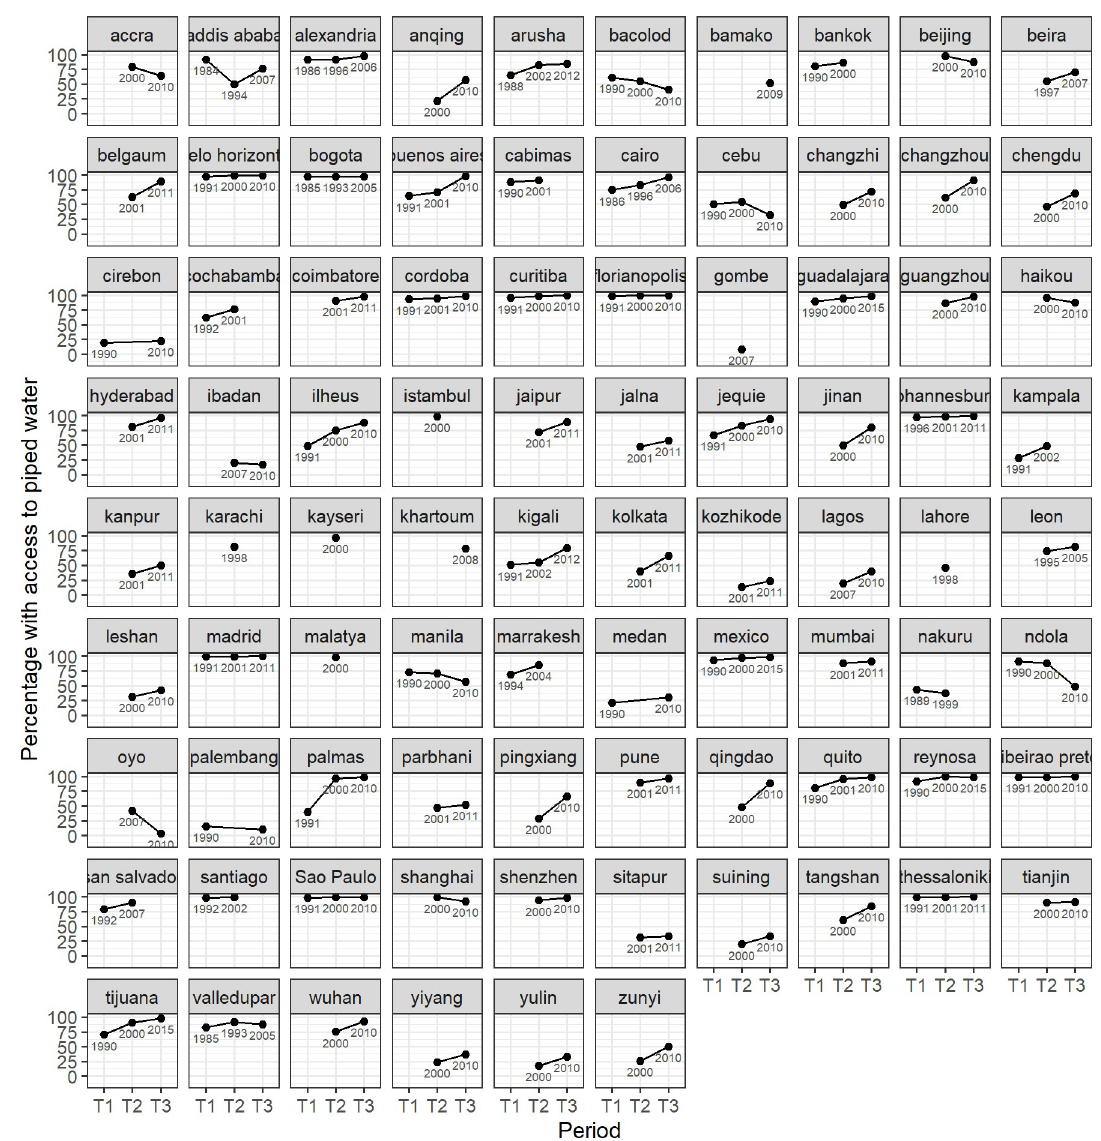
Fig 7. Percentage of households with access to piped water in 86 cities at different moments in